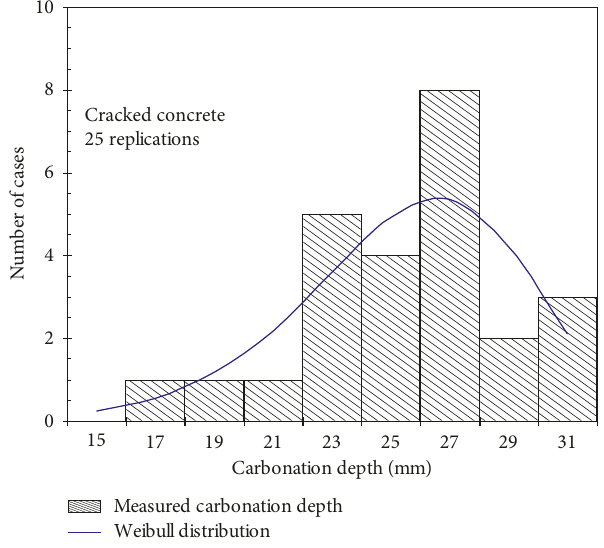
Figure 5: Distribution of carbonation depth values obtained from field data for cracked